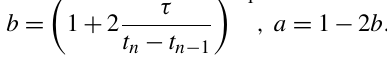
the sensor reads the true oxygen concentration correctly